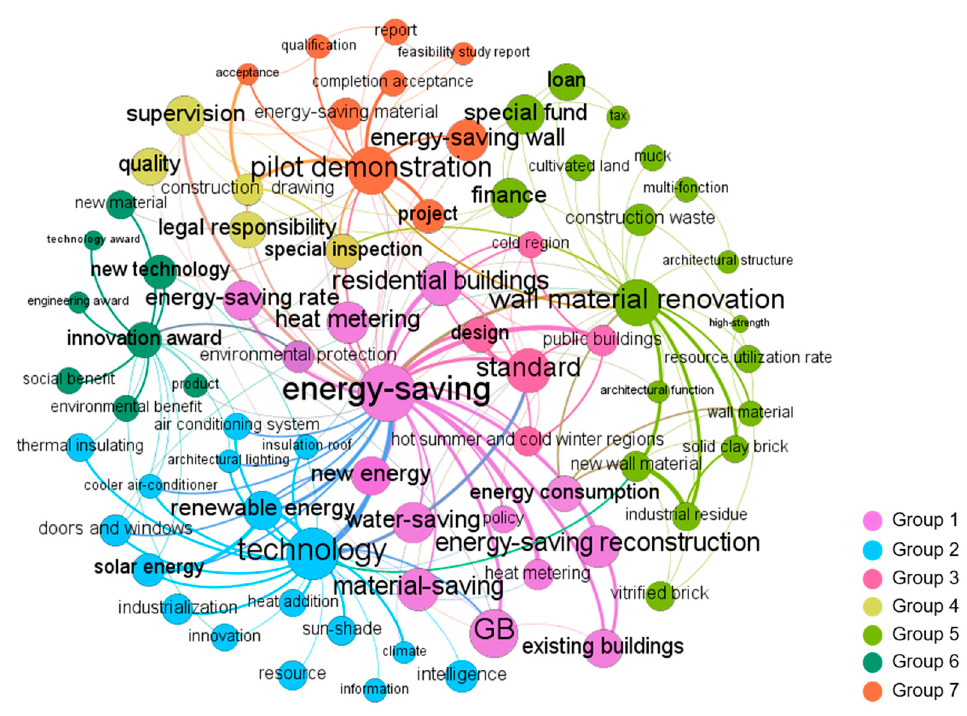
Figure 3. Co-word network of China’s GBPs in stage